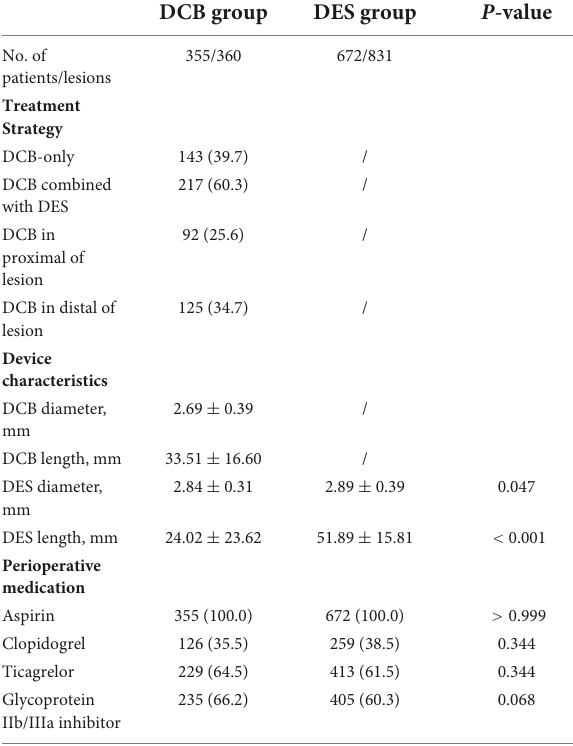
TABLE 2 Characteristics of procedures and lesions. TABLE 3 Device characteristics and perioperative